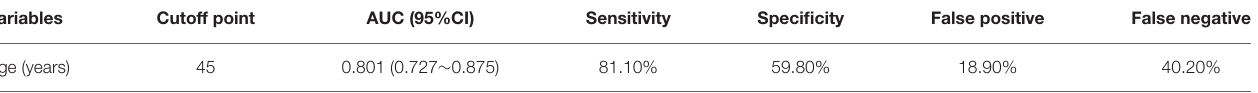
AUC, area under the curve; CI, confidence interval.